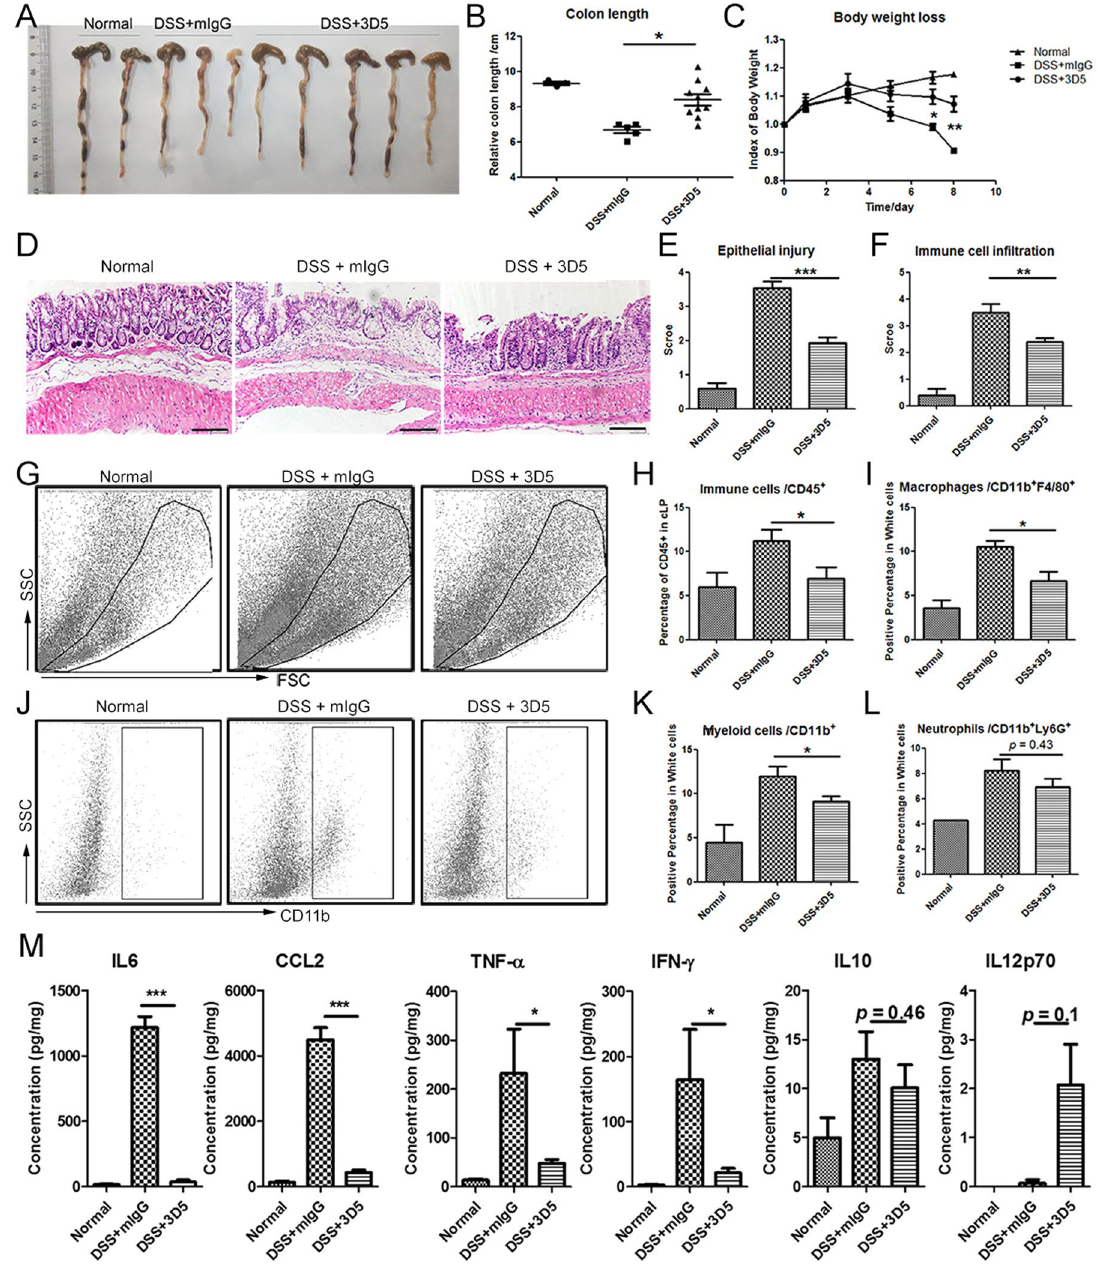
Figure 5. The neutralizing antibody of PSMP mollified DSS-induced colitis via its effects on the monocytes/ macrophages and IL-6, TNF- α , CCL2, IFN- γ . Based on the DSS-induced colitis, PSMP neutralizing antibody 3D5 (5 mg/kg) or mouse immunoglobulin G (mIgG) as a negative control were peritoneal injected every other day. ( A ) The colons were separated from the normal, DSS-induced colitis and 3D5-treated DSS-induced colitis groups. ( B ) and ( C ) The lengths of the colons and the body weight of the three groups were measured and statistically analyzed. ( D ) The colonic tissue biopsies from the three groups were stained with HE. Scale bar = 100 μ m. ( E ) and ( F ) The colonic inflammatory score of the three groups were statistically analyzed based on the conditions of the colonic epithelial injuries and immune cell infiltration of cLP. ( G ) The immune cells that infiltrated the cLP in the three groups were separated and analyzed by flow cytometry. The Gate in the FSC-SSC graph displayed the distribution of immune cells. ( H ) The immune cell (CD45 + ) infiltrations in the three groups were statistically analyzed. ( I ) The percentages of macrophages (F4/80 + ) among all of the immune cells in the cLP of the three groups were statistically analyzed. ( J – L ) The myeloid-derived cells (CD11b + ) and granulocytes (Ly6G + ) in the total immune cells of the three groups’ cLP were displayed in the CD11b-SSC graph and were statistically analyzed. ( M ) The inflammatory cytokines IL-6, TNF- α , CCL2, IFN- γ , IL-10 and IL-12p70 were detected in the colonic tissue homogenates by CBA, and the concentrations of these cytokines in the colon tissues of the three groups were statistically analyzed. Data were representative of at least three independent experiments with five mice per group. * 0.01 < p < 0.05, ** 0.001 < p < 0.01, and *** p <